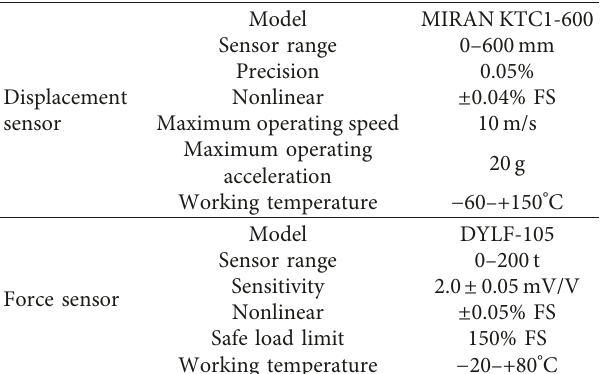
Figure 1: Schematic of hydraulic impact test machine. Table 2: Sensor